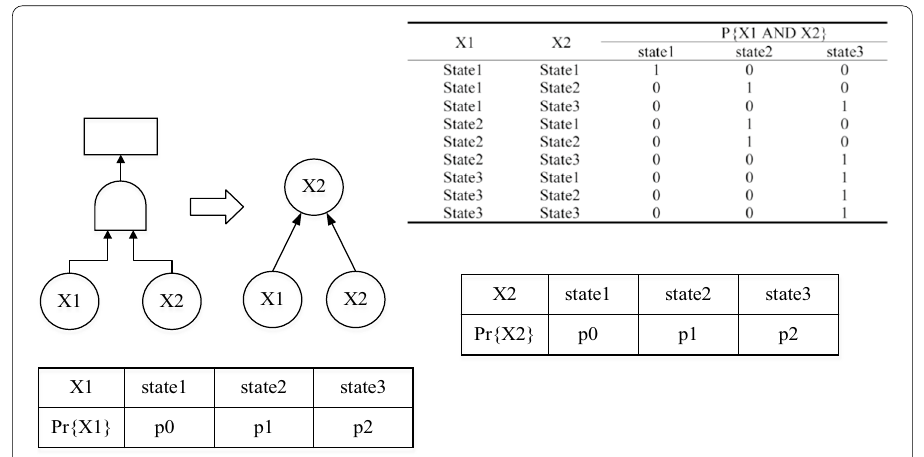
Fig. 8 BN’s CPT of AND gate